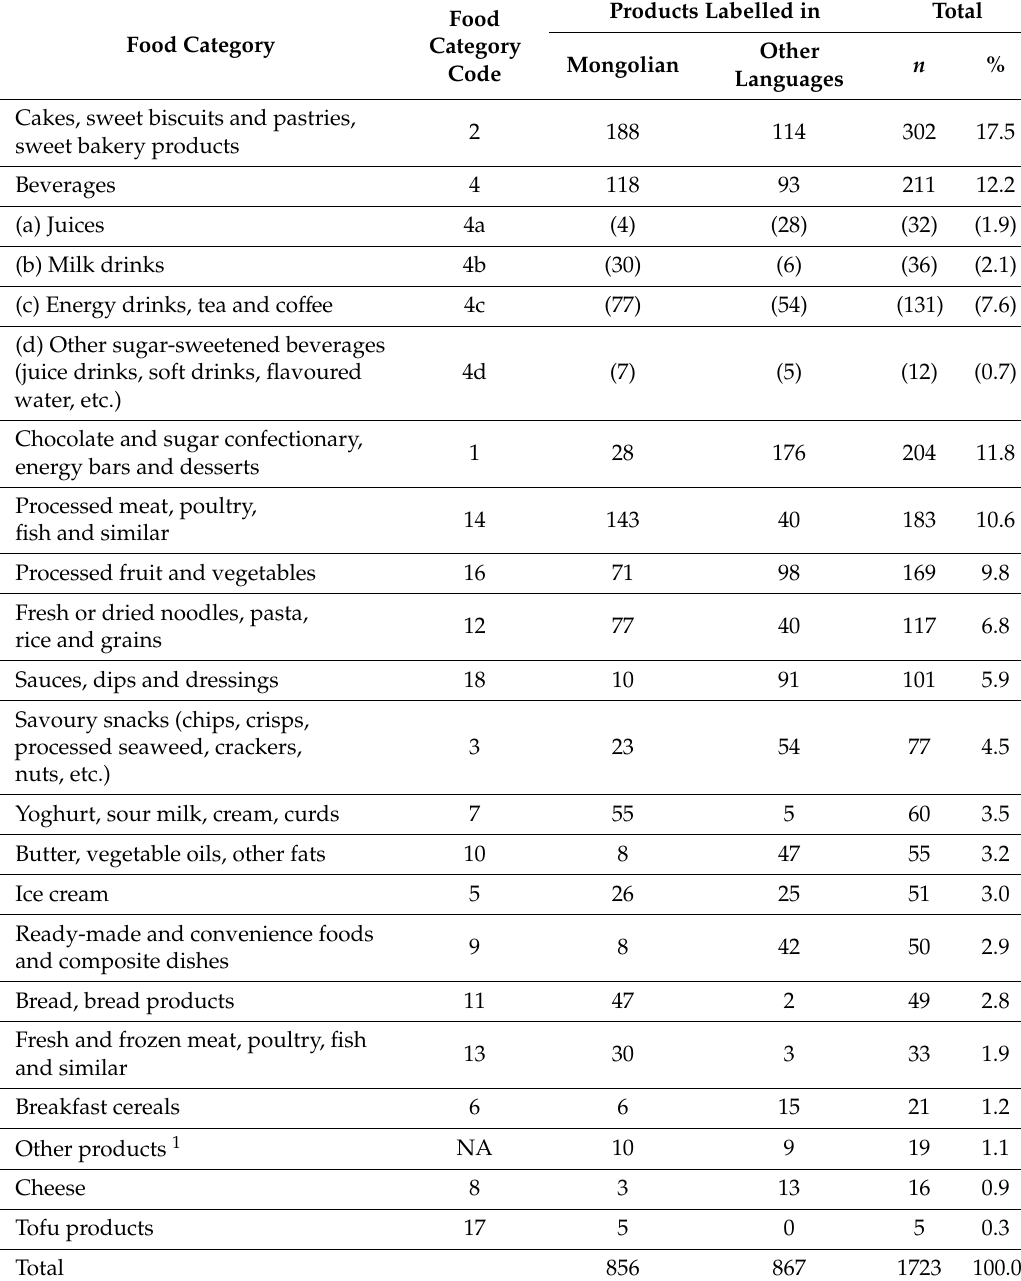
Table 2. Food categories covered in the